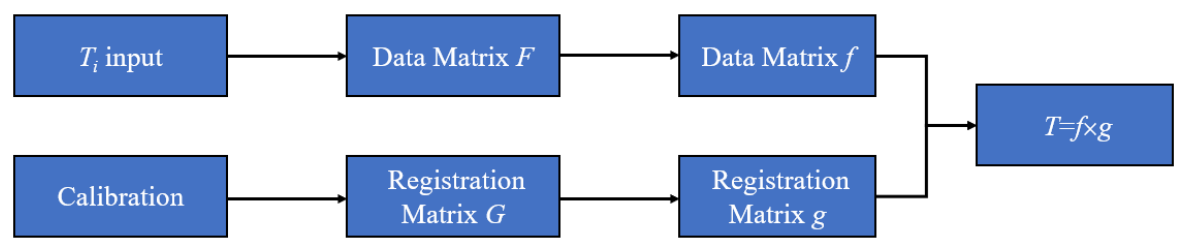
Figure 11. Data registration procedures.